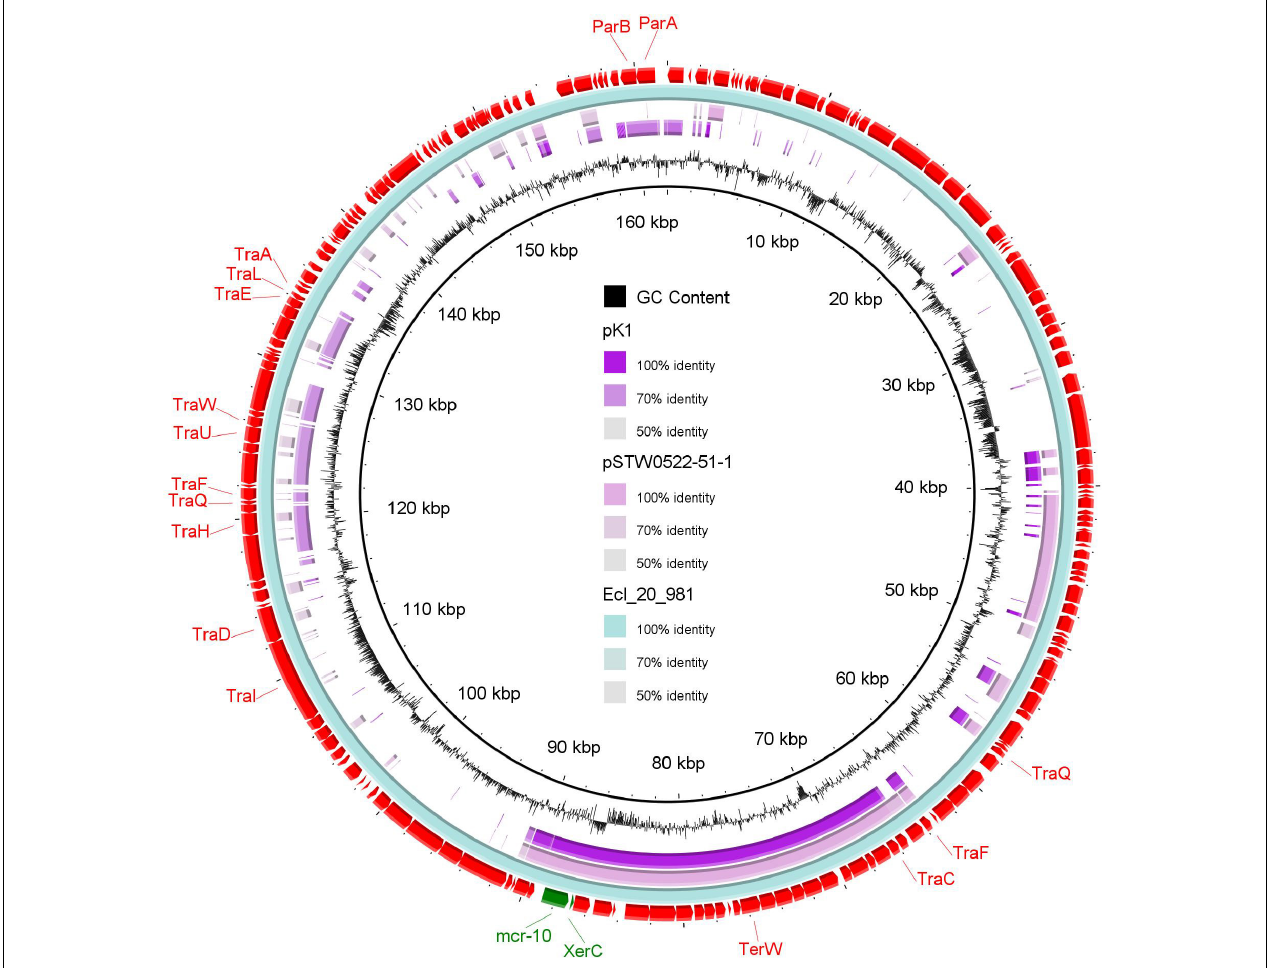
FIGURE 1 | A circular map of the reconstructed IncFIB plasmid (pK1) from the draft genome sequence of K. pneumoniae (study isolate) compared to two NCBI retrieved plasmids, pEcl_20_981 of Enterobacter roggenkampii strain Ecl_20_981 (CP048651.1) and pSTW0522-51-1 of Enterobacter kobei strain STW0522-51 (AP022432.1). The out-layer circle (red color) represents plasmid pEcl_20_981, which used as the reference plasmid for sequence comparisons. The figure was generated using BLAST Ring Image Generator (BRIG) tool (http://sourceforge.net/projects/brig).